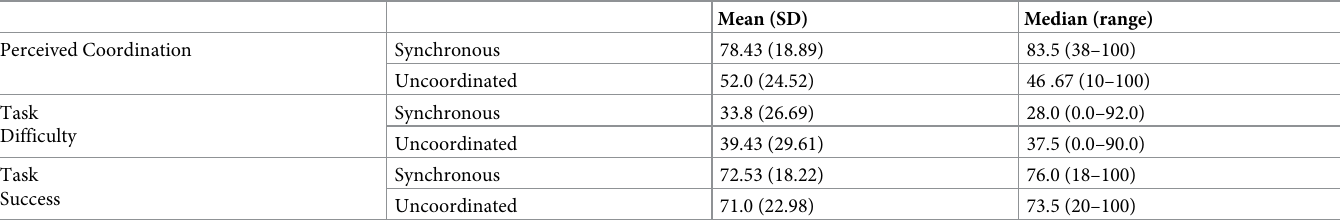
Table 5. Descriptive statistics for the manipulation check questions in Study